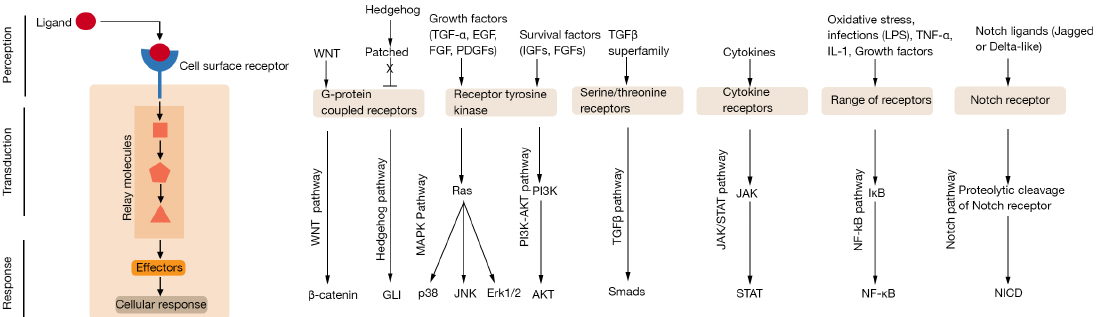
Figure 1. Overview of major cellular signalling process and pathways. Cell surface receptors receive instructional signals from the environment through interaction with extracellular ligands. This signal is then transduced across the plasma membrane where intracellular second messengers amplify and relay the information to elicit cellular responses. Ligands that utilise common signalling pathways and associated transcription factors are depicted in the left panel (an excellent resource for an overview of cellular signalling pathways can be found at the Internet resource: Cell Signaling Pathways by Michael Berridge